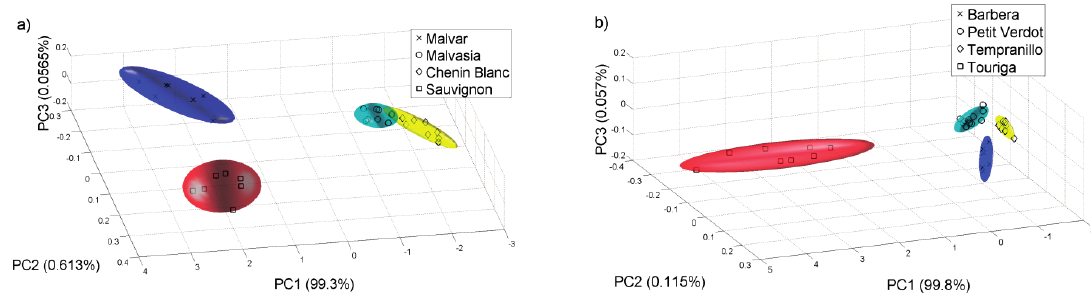
Figure 7. PCA analysis for the samples collected on 22 of August of 2011. ( a ) White varieties; ( b ) Red